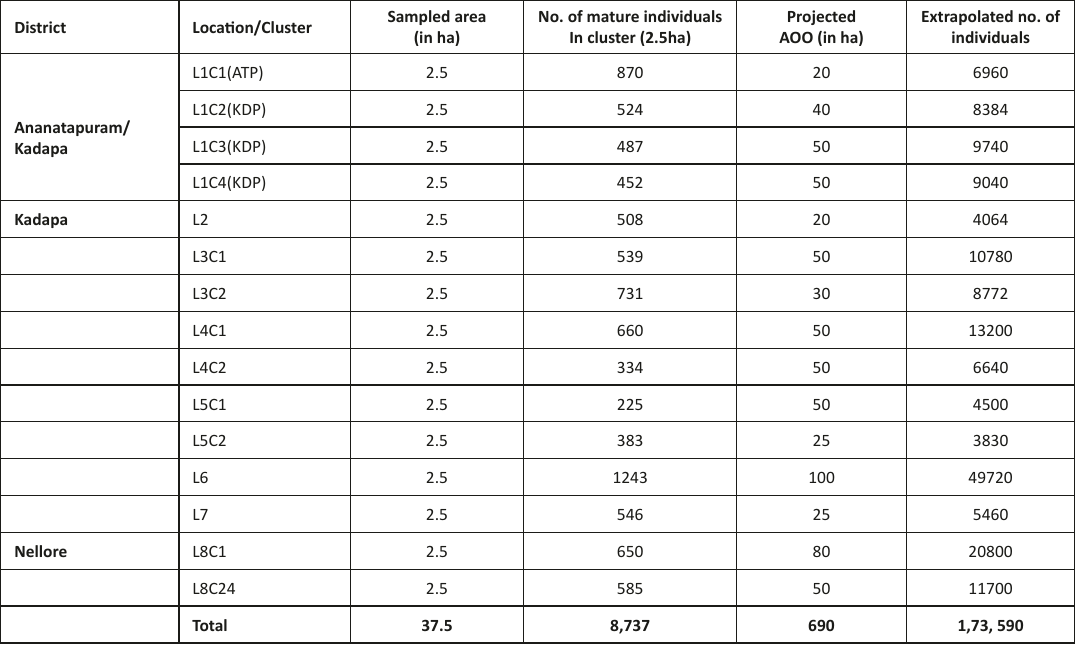
Table 2. Estimated population size of Croton